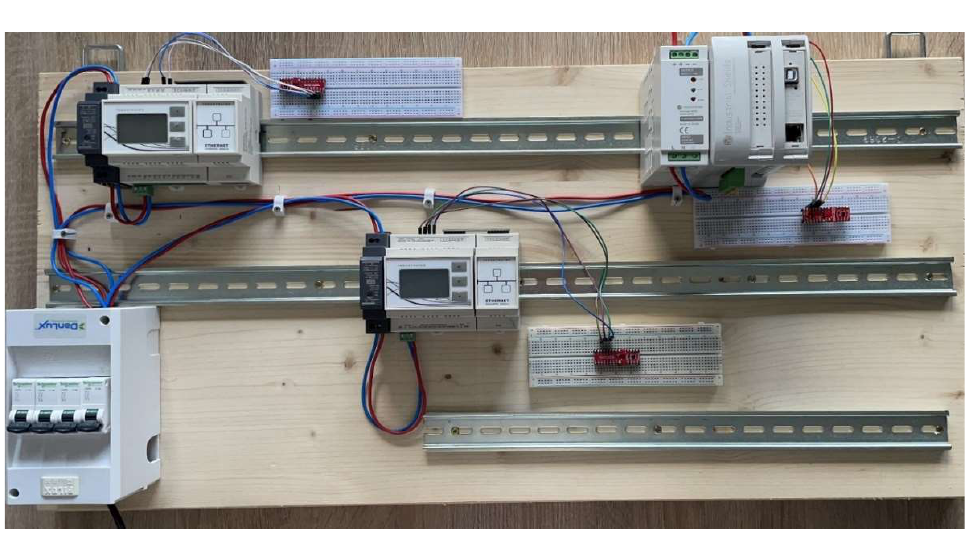
Figure 4. Experimental setup with three Optiga Trust X modules. Cryptographic Library Setup